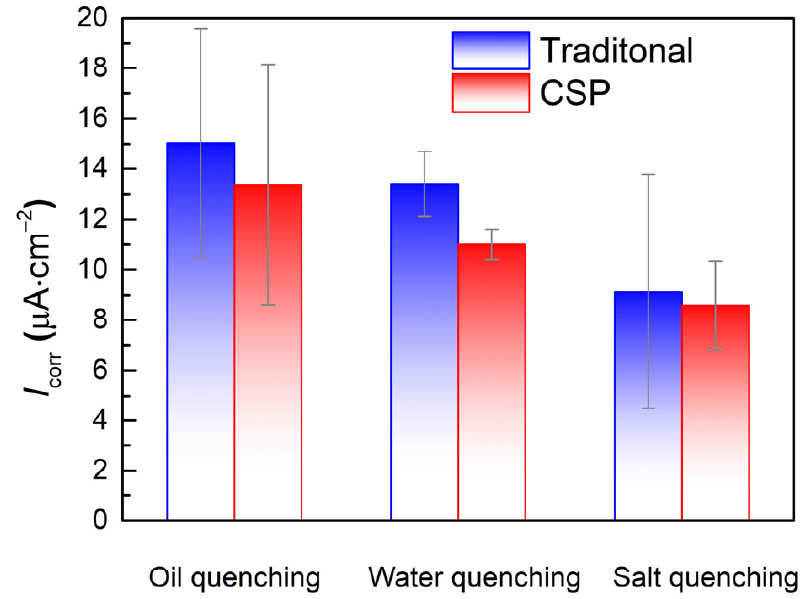
Figure 6. Calculated corrosion current density for the samples produced by traditional and CSP processes quenched in the different quenching mediums.